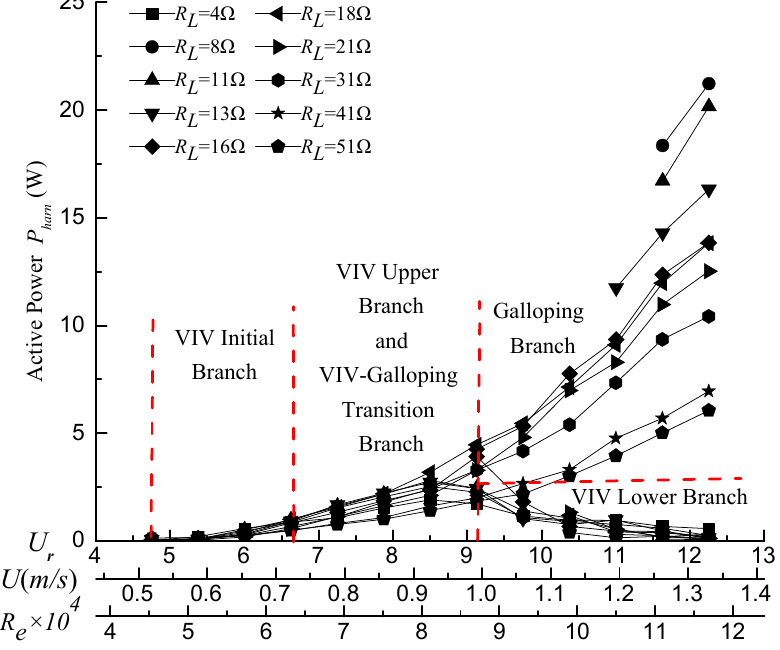
Figure 14. T-section prism power generation active power.